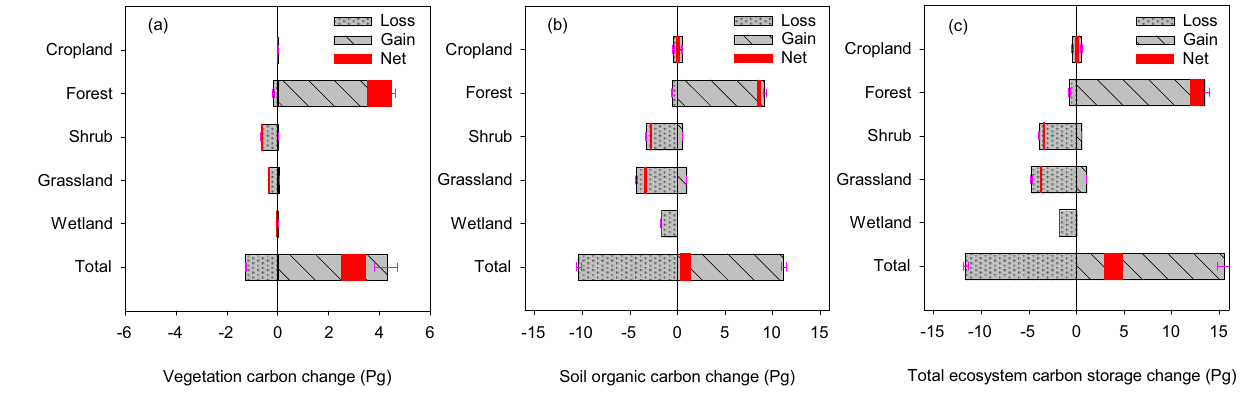
Fig. 6 | LUCC-induced carbon storage changes by land cover types based on model simulations during 1980 – 2019. Panel a – c indicate vegetation carbon, soil organic carbon, and total ecosystem carbon, respectively; the widths of the red